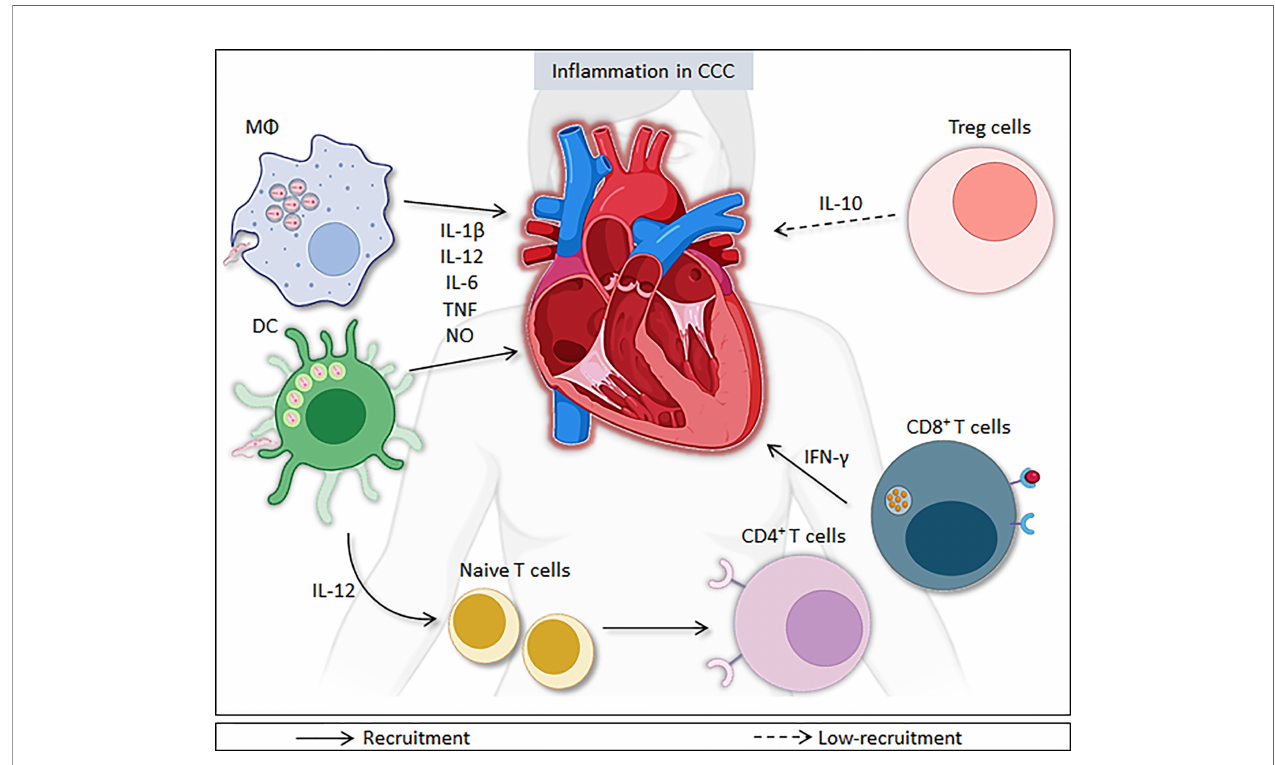
FIGURE 1 | Immune responses during Trypanosoma cruzi infection. After activation via Toll-like receptors, innate immune cells, such dendritic cells and macrophages, produce pro-in fl ammatory molecules, such as IL-1 b , IL-6, IL-8, IL-12, TNF, and nitric oxide, which help in combating the parasite. However, these molecules contribute to in fl ammation in the heart in both phases of disease. IL-12 production promotes a shift towards Th1 lymphocyte pro fi le. CD4 + and CD8 + T cells, mainly through the production of IFN- g , contribute to the activation of other immune cells and increase the production of pro-in fl ammatory molecules, such as IL-12, TNF, and nitric oxide, cooperating for the control of infection. The persistence of high levels of pro-in fl ammatory cytokines, such as IFN- g and TNF, and the increase in IFN- g -producing CD4 + and CD8 + T lymphocytes contribute to the persistence of in fl ammation in heart. Moreover, the low-recruitment of T-regulatory cells (Treg) and reduced IL-10 production also favor the persistence of heart in fl ammation in